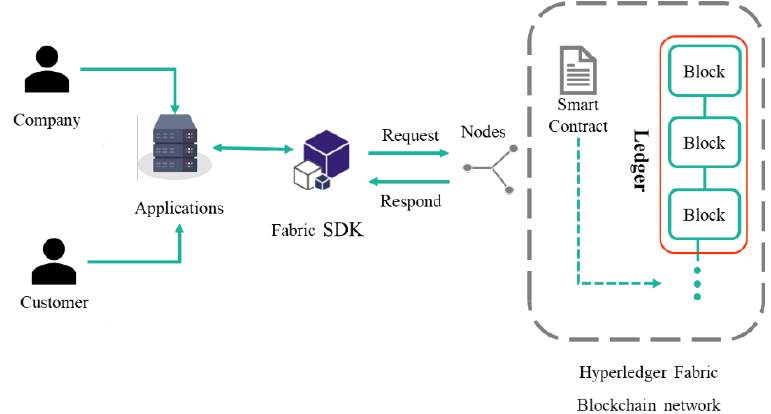
Figure 2. Interactions between users and the blockchain network.